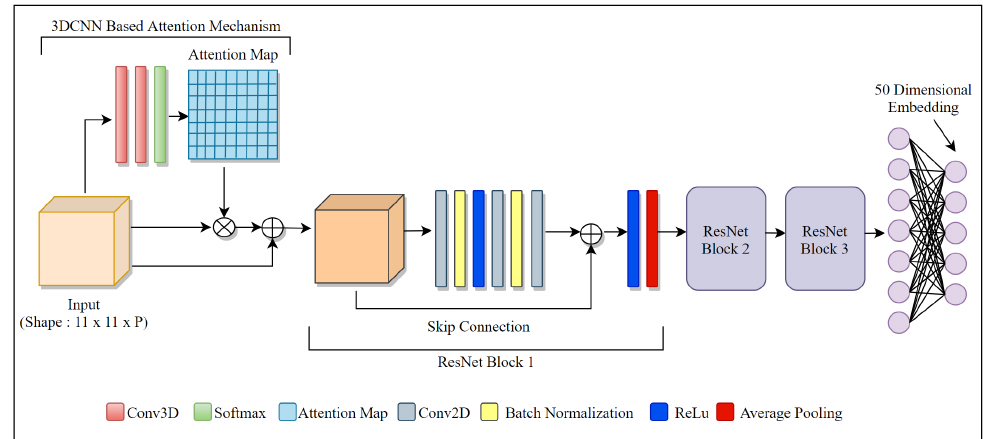
Figure 3. The architecture of the proposed 3D-CNN-based spatial attention and ResNet-based feature extraction module from Figure